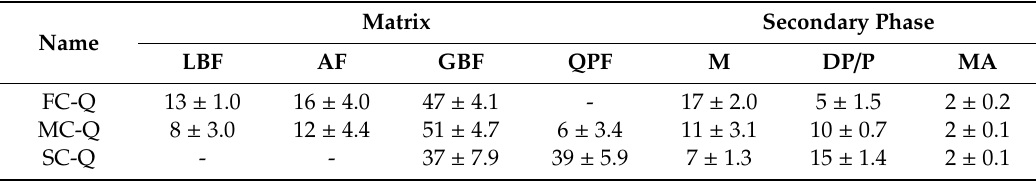
Figure 4. ( a – c ) Optical and ( d – f ) scanning electron micrographs of Q specimens etched by 4% Nital. ( a , d ) FC (−10.6 °C/s), ( b , e ) MC (−4.6 °C/s), ( c , f ) SC (−2.5 °C/s). (LBF: lath bainitic ferrite, AF: acicular ferrite, GBF: granular bainitic ferrite, QPF: quasi-polygonal ferrite, M: martensite, DP: degenerated pearlite, MA: martensite–austenite constituent). Table 3. Microstructure and area fraction (%) of experimental steel according to the CR in the quenching-only treatment,